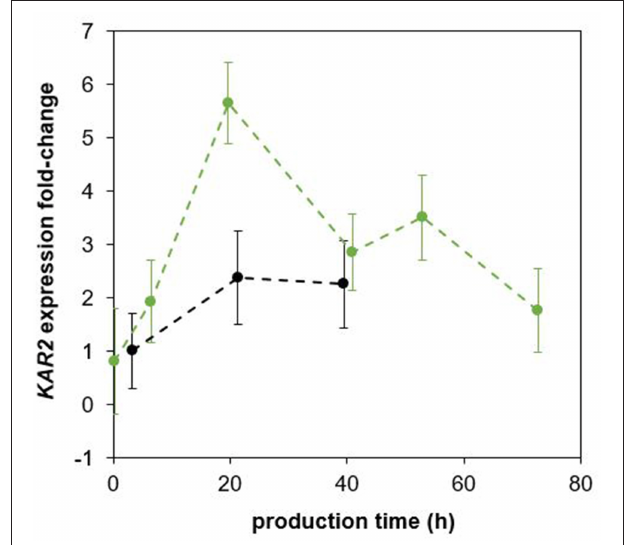
FIGURE 3 | Fold-change of KAR2 expression in the P. pastoris strain producing Ec PGA and the non-producing control strain as obtained by qPCR analysis. The P. pastoris strains producing Ec PGA (green) and the control non-production strain (black) were cultured under the same cultivation conditions (30 ◦ C, pH 5.5), maintaining the specific growth rate of biomass with methanol at 0.016 h − 1 . All relative expression data are related to the expression of KAR2 in the non-producing control strain in the sample taken 3h after